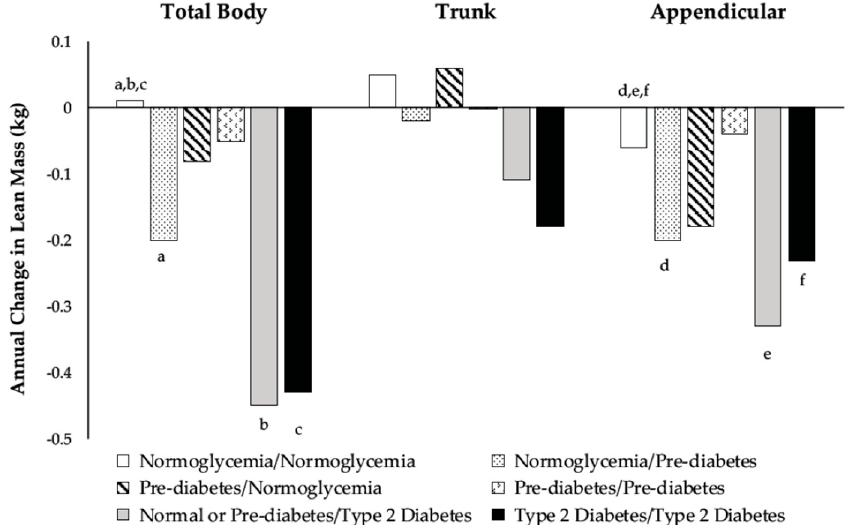
Figure 3. Adjusted marginal means of annual change from baseline in total body ( p = 0.004), trunk ( p = 0.24), and appendicular ( p < 0.001) lean mass according to categories of glycemic status during the three-year follow-up. Model included baseline age, height, population group, percent time in moderate-plus-vigorous activity, average caloric intake, baseline measures of fat and lean mass in the specific body compartment (total body, trunk, or appendicular), changes in percent time in moderate-plus-vigorous activity and average caloric intake, and annual change in the fat mass of the same compartment. Means with similar superscripts are different using post hoc contrast tests based on hypotheses.